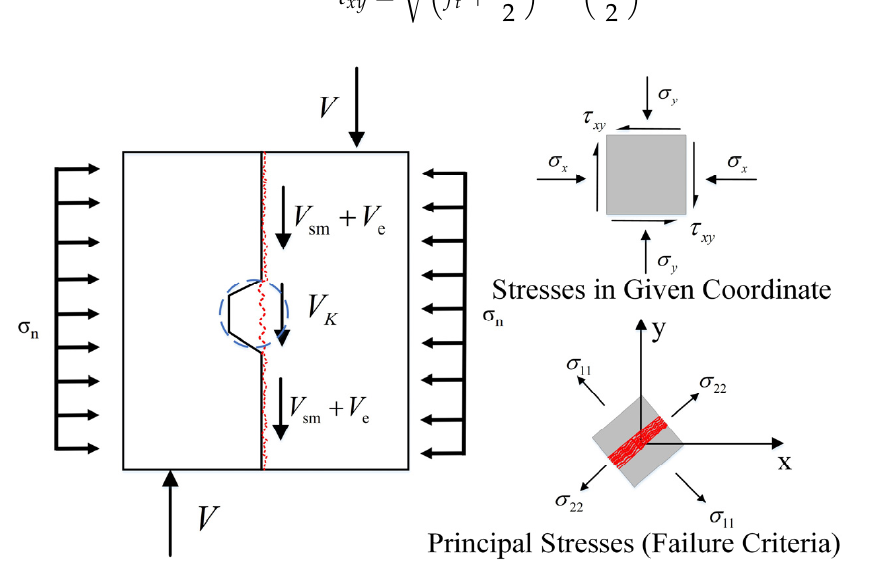
Figure 10. Proposed shear model for UHPC precast keyed joints.